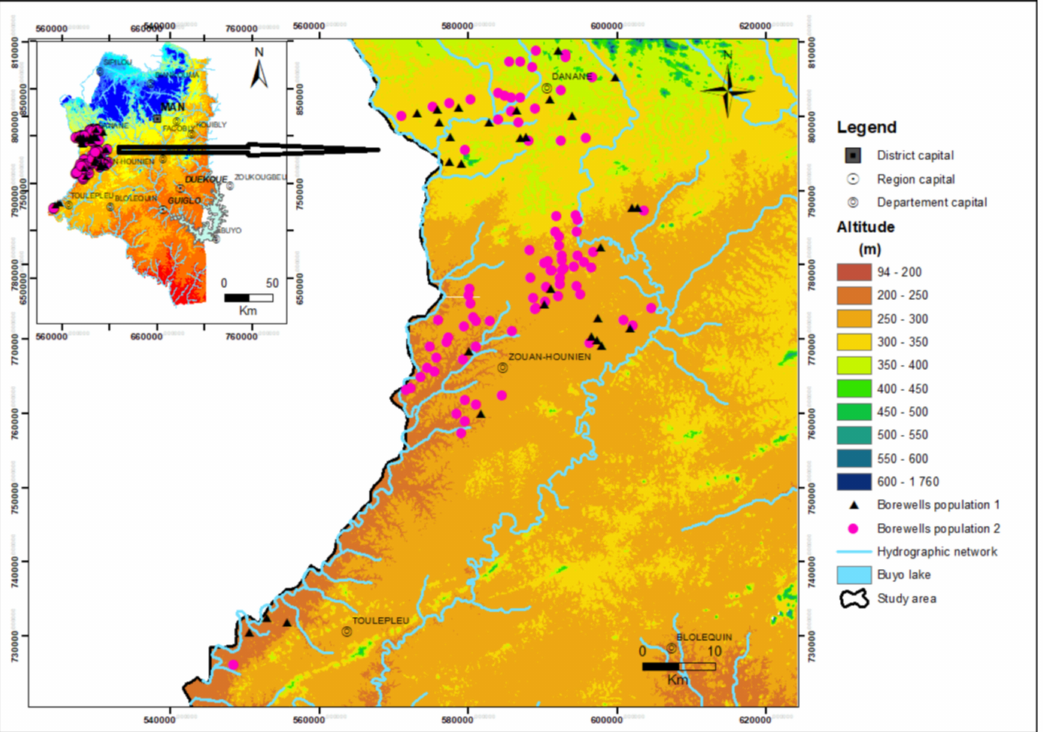
Figure 12. Spatial distribution of borewells population 1 (N = 30) and population 2 (N = 89) on the DEM for the Biotite Granodiorite and Biotite